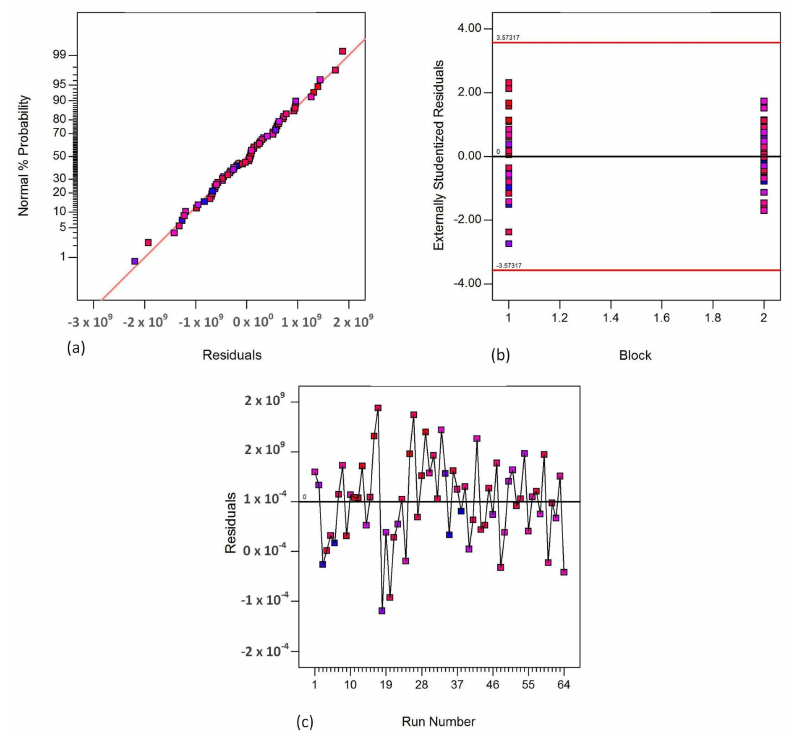
Figure 6. Fisher assumptions ( a ) residual normality; ( b ) equality of variance and ( c ) run-order independence for flexural modulus.